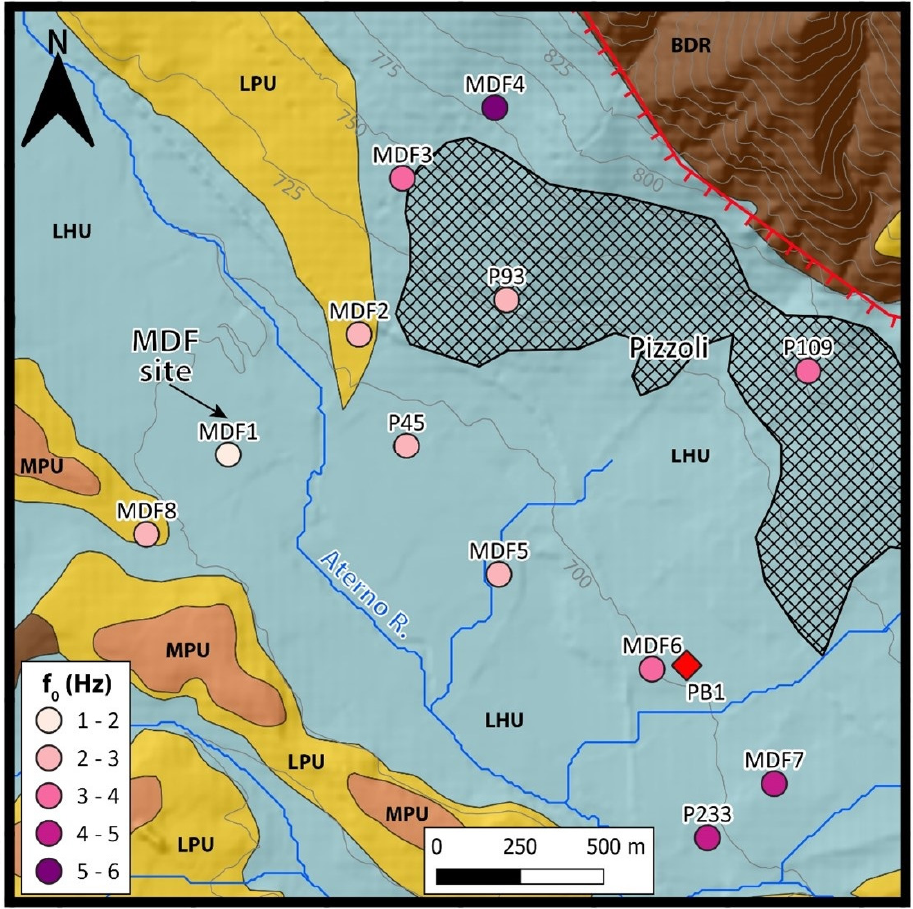
Figure 5. Distribution of resonance frequency (f 0 ) from H/V noise spectral ratios over the MDF area. The colors of the circles are proportional to the f 0 values. With the red diamond the location of the PB1 borehole is shown.